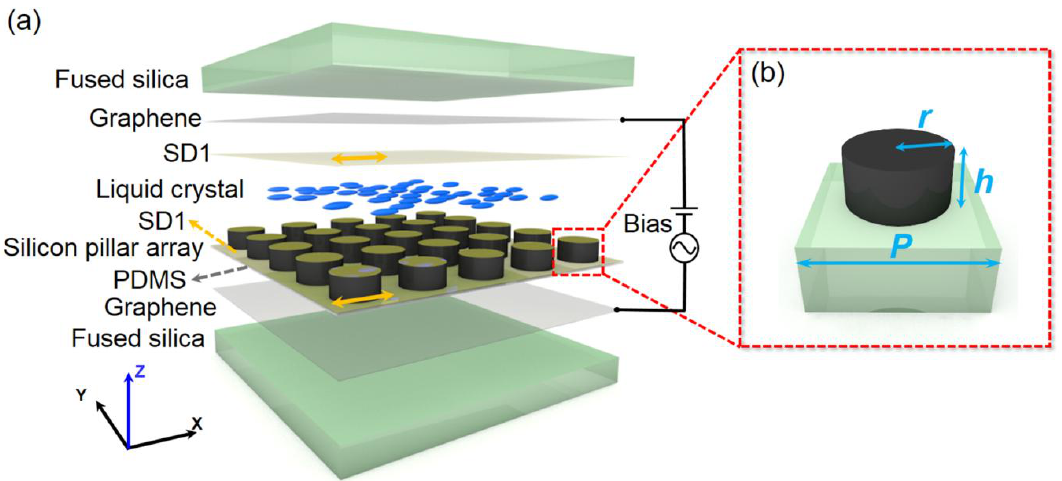
Figure 1. ( a ) The decomposition diagram of the LC integrated dielectric MMA. The yellow arrows indicate the alignment direction. ( b ) The unit dimension of the pillar resonator: lattice periodicity, p : 210 μm; radius, r : 64 μm; height, h : 60 μm.